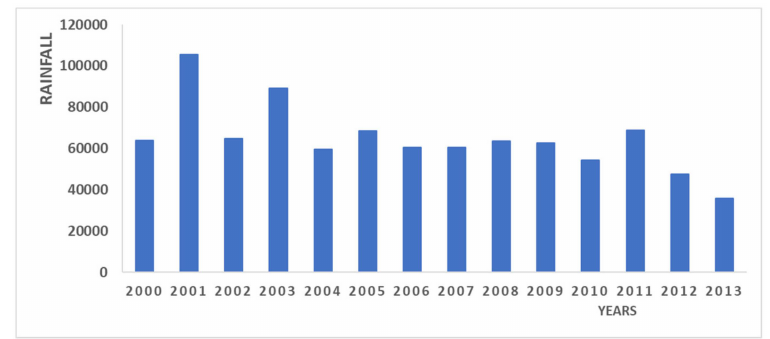
Figure 6. Annual average rainfall in the Three Parallel Rivers from 2000 to 2013.